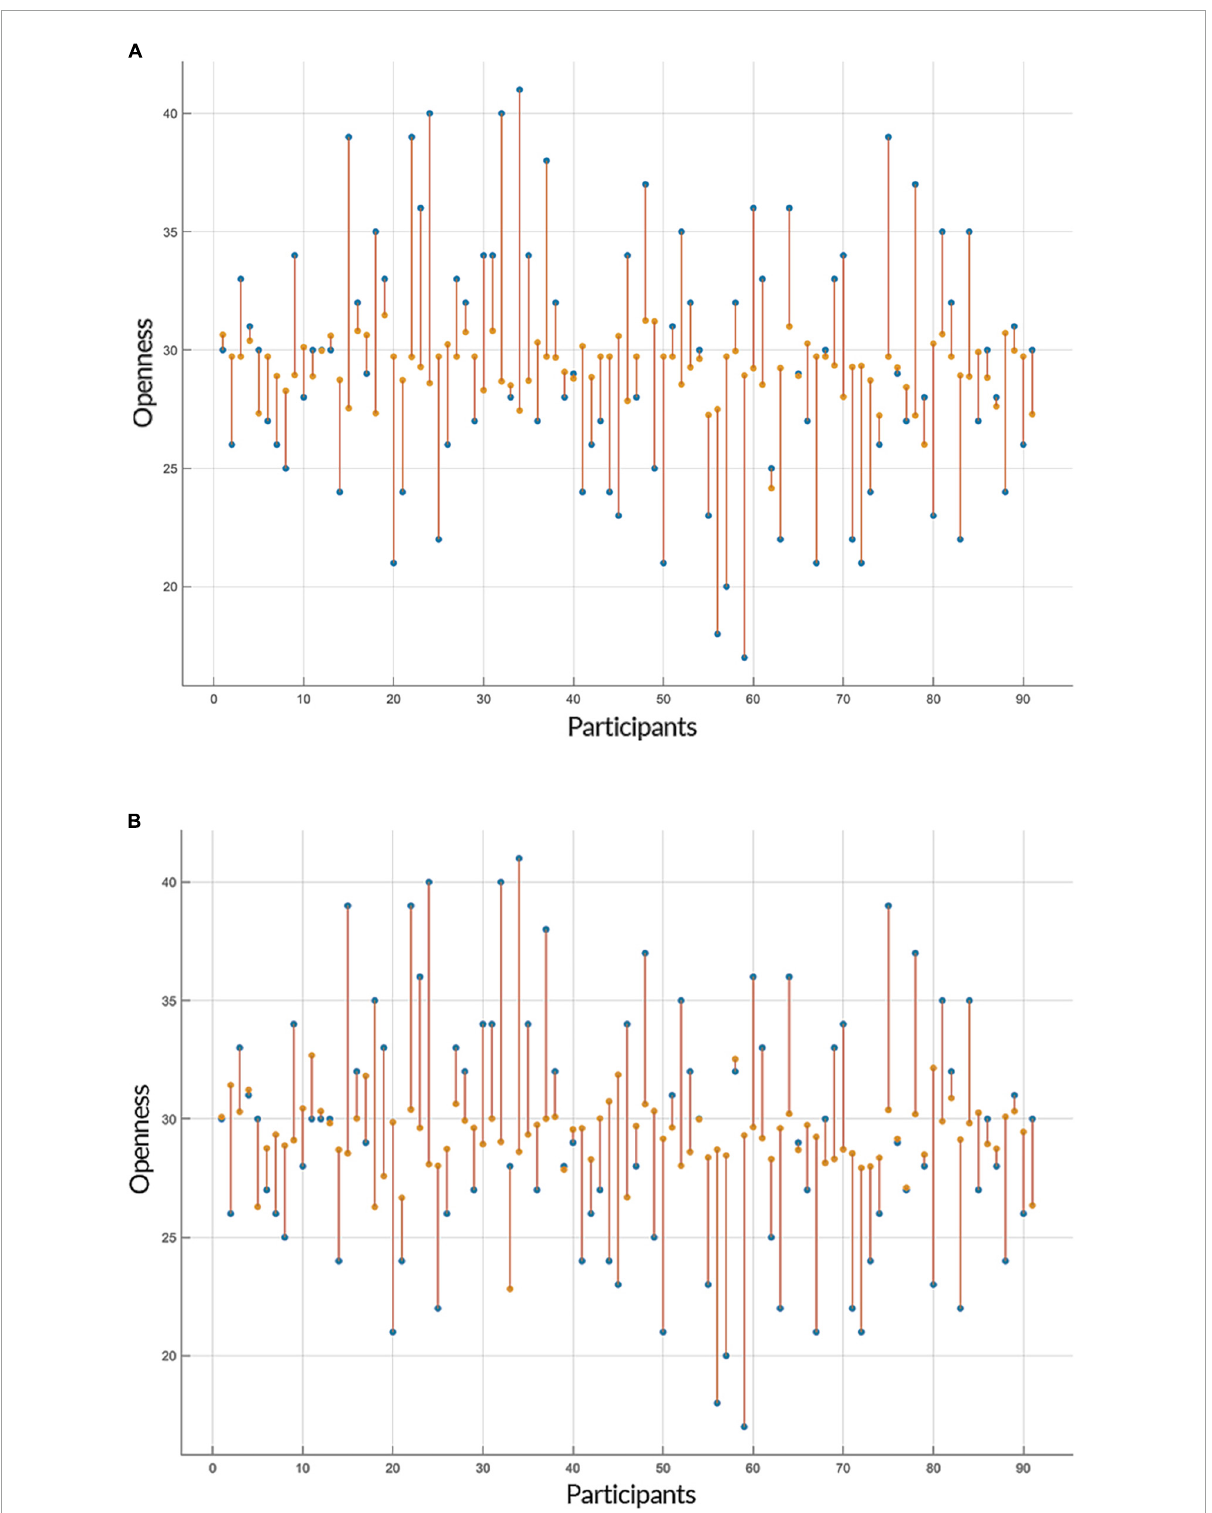
FIGURE4 Prediction of openness to experience based on clustering coefficient (CC) scores. Similar to Figure 3 , the plots show the result of the prediction of openness to experience scores (y-axis) of each subject (x-axis) by (A) Gaussian Process Regression (GPR) and (B) linear regression, but this time based on the openness to experience and CC scores as inputs. The predicted values are shown in orange and the actual data points are in blue. The orange lines depict the difference between predicted values and the actual